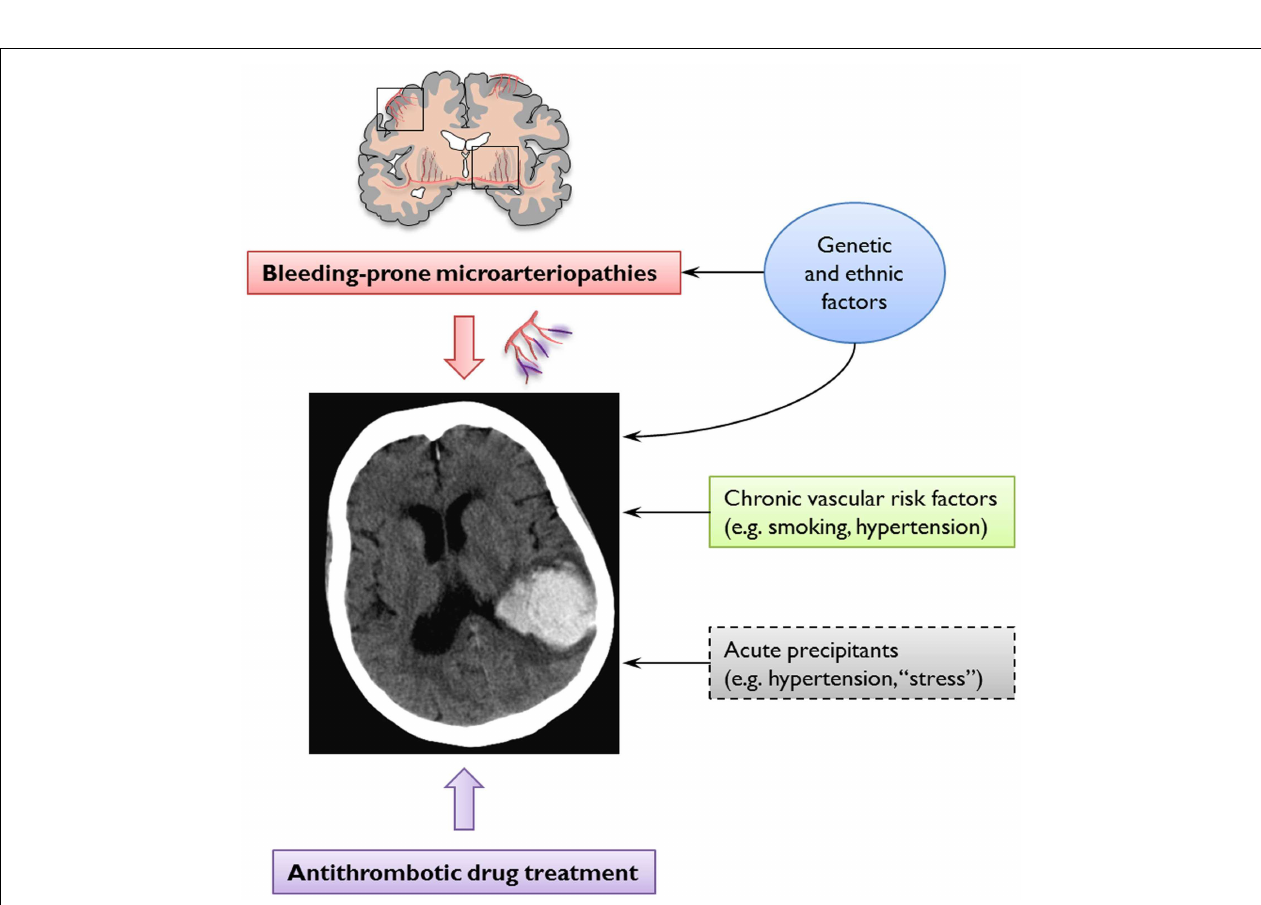
and cardiovascular risk factors. Acute trigger factors for example, sudden increases in blood pressure or minor trauma may cause the rupture of these abnormally weak vessels. Anticoagulation may promote ICH by allowing an otherwise innocuous minor and self-limiting vessel leak to expand into a life-threatening